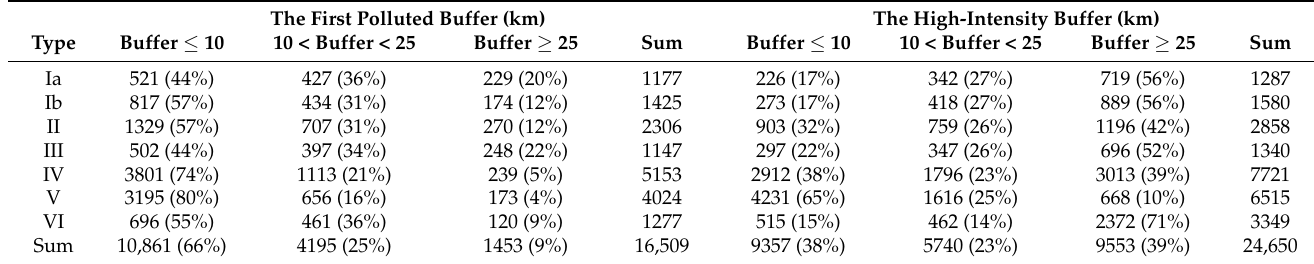
Table 2. Number and types of polluted PAs with different distances to the averaged first and high-intensity polluted buffer.